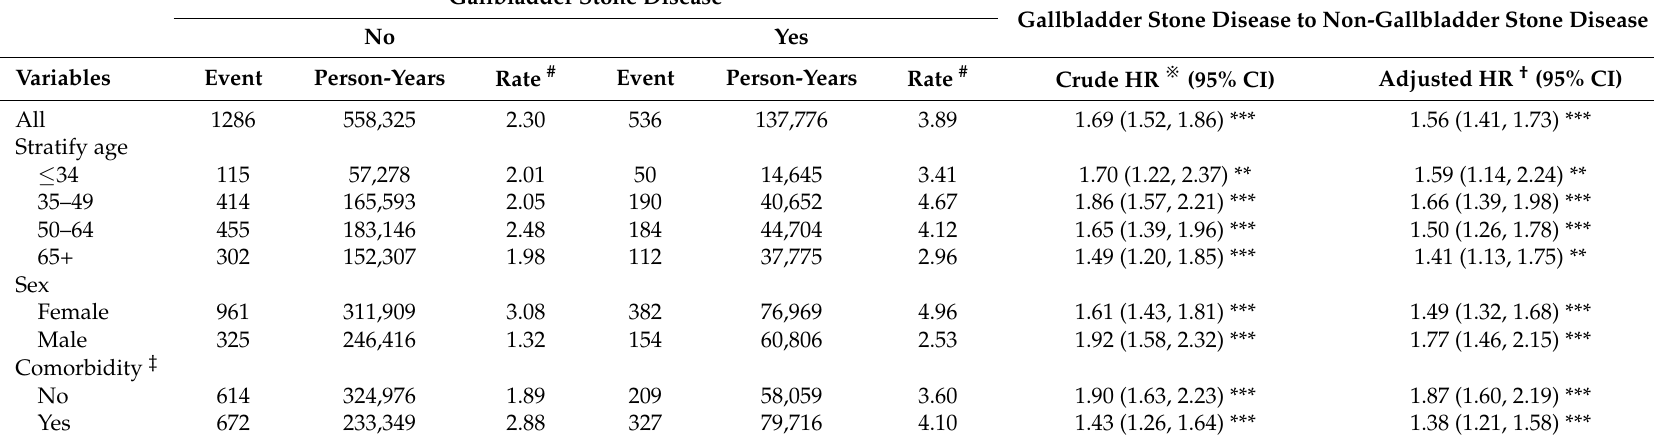
Table 2. Incidence of migraine by age, sex, and comorbidity, with Cox model-measured hazards ratios for patients with gallbladder stone disease compared with those without gallbladder stone